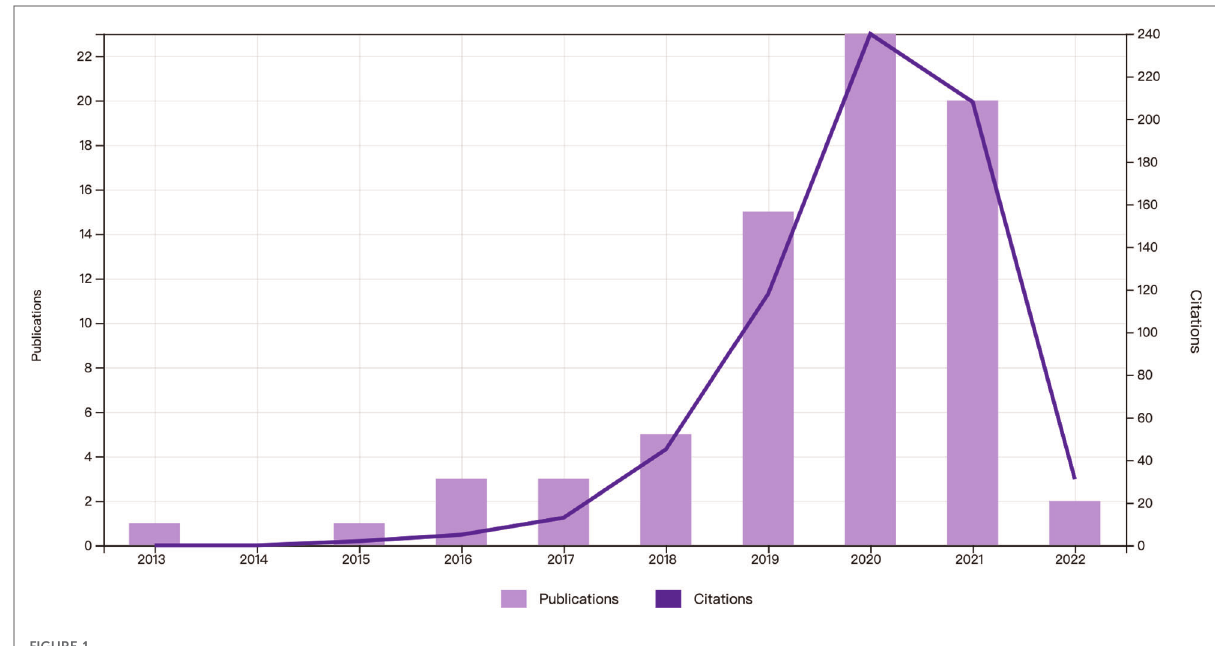
FIGURE 1 The annual trends of publications.